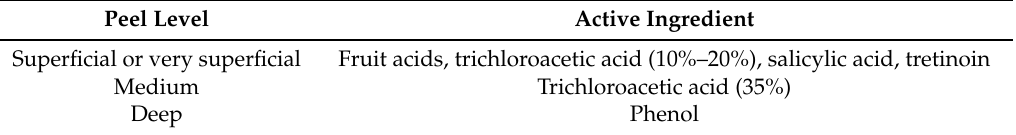
Table 2. The different categories of